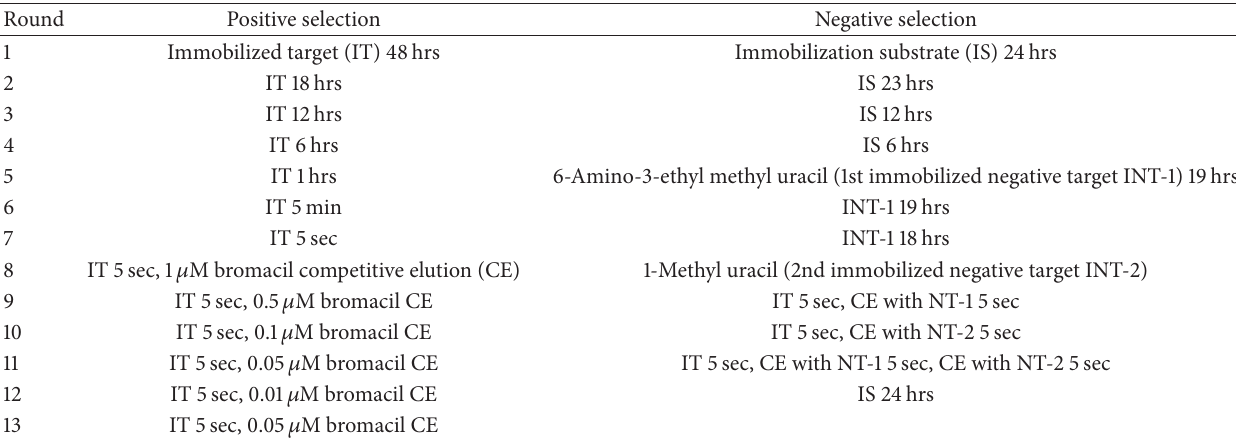
Table 1: SELEX scheme for selection of a bromacil-specific MRE.